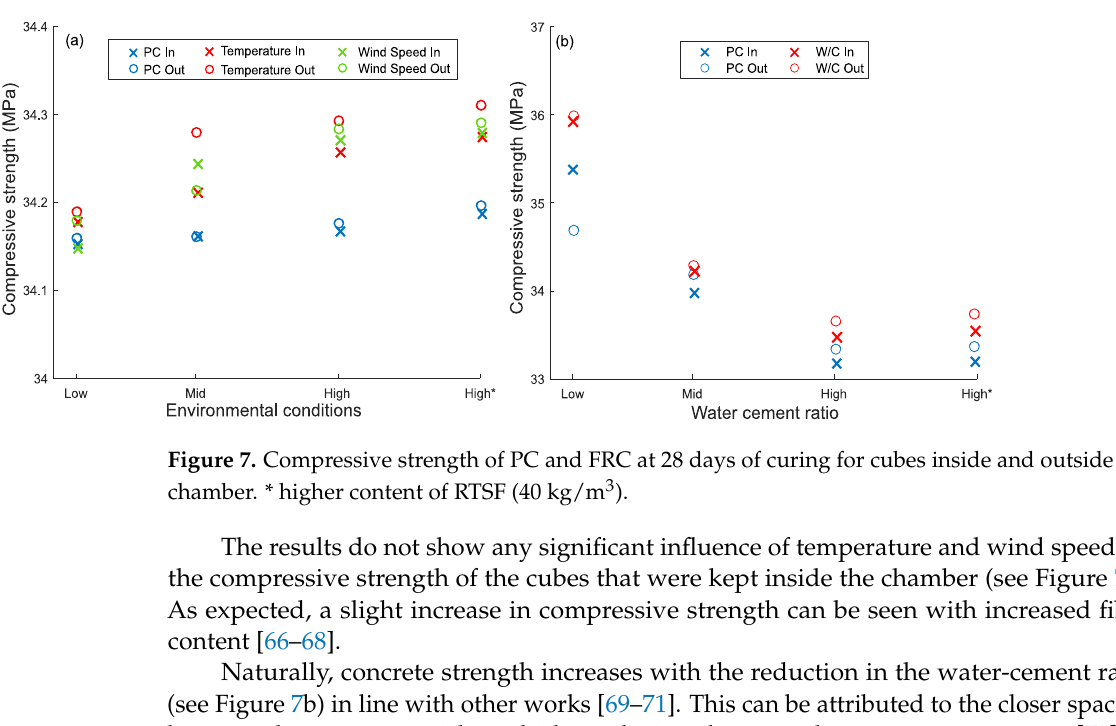
Figure 7. Compressive strength of PC and FRC at 28 days of curing for cubes inside and outside the chamber. * higher content of RTSF (40 kg/m 3 ).